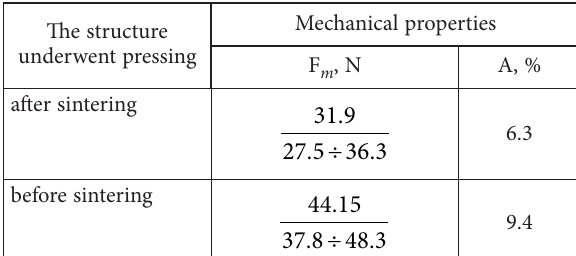
Figure 5. Quantitative distribution function of diffusion bridges between